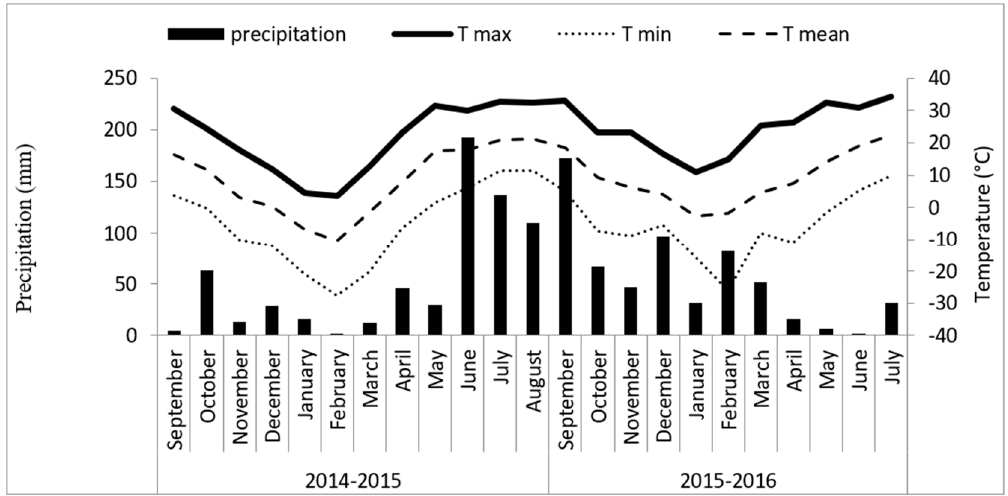
Figure 1. Monthly precipitation and average, maximum and minimum temperature during 2014–2016 growing seasons.